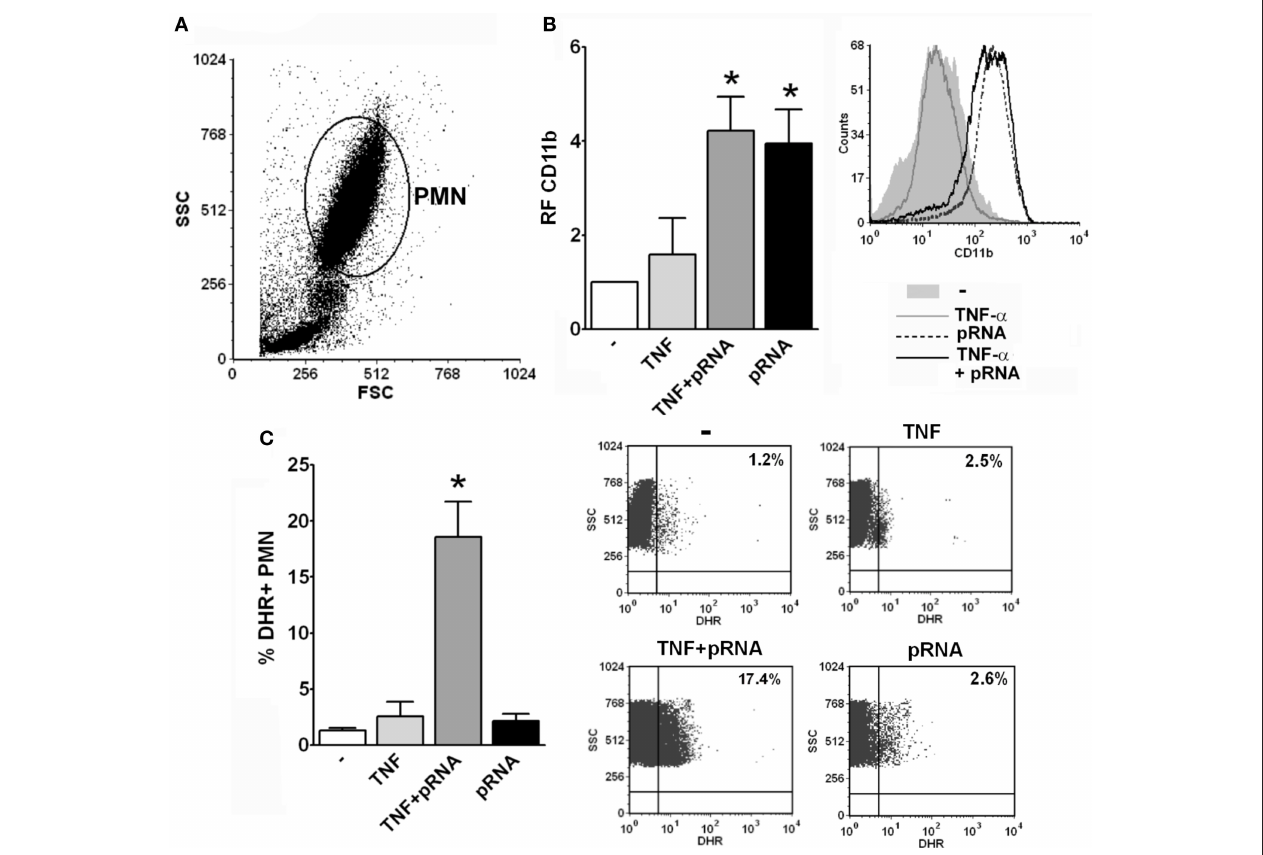
FIGURE 6 | pRNA-induced ROS requires priming. (A) Representative dot-plot showing the SSC vs. FSC profile of the different populations observed in whole blood assays after lysis of erythrocytes using a commercial lysing buffer. The PMN population is indicated. (B) Whole blood was incubated with pRNA and/or the priming stimulus, TNF- α , for 30 min and the expression of CD11b was measured by flow cytometry within the gate of PMN. A histogram of one representative experiment out of three is shown. (C) Whole blood was incubated with DHR for 15 min and with the different stimuli for additional 30 min. The % of DHR + PMN was determined by flow cytometry within the gate of PMN. Dot-plots of the percentage of DHR + PMN of one representative experiment out of three are shown. In all cases * p < 0.05 vs. all other